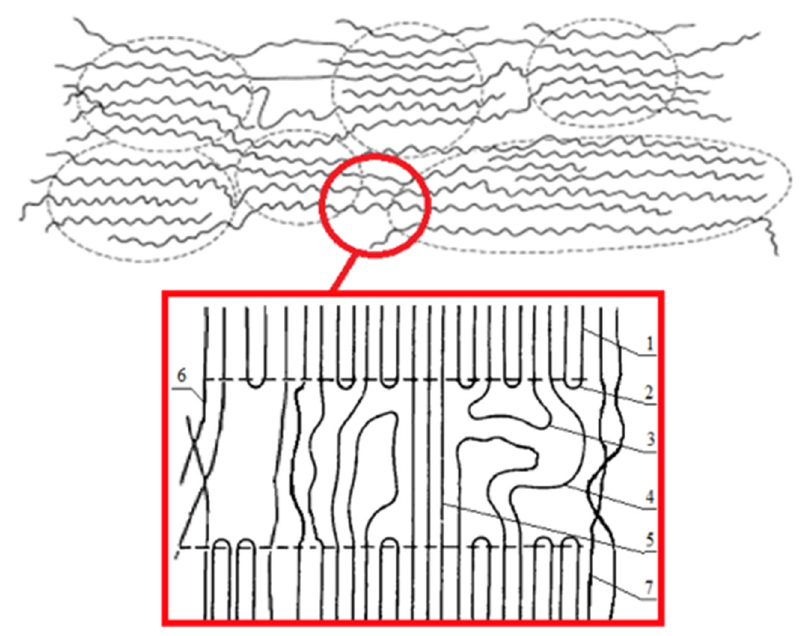
Figure 5. The organization of PHB macromolecules: 1—crystal regions; 2—regular chain fold; 3— irregular chain fold (free loop); 4—pass-through molecules; 5—the shortest, elongated and stressed pass-through molecules; 6—interfibrillar pass-through chains; and 7—interfibrillar structures.